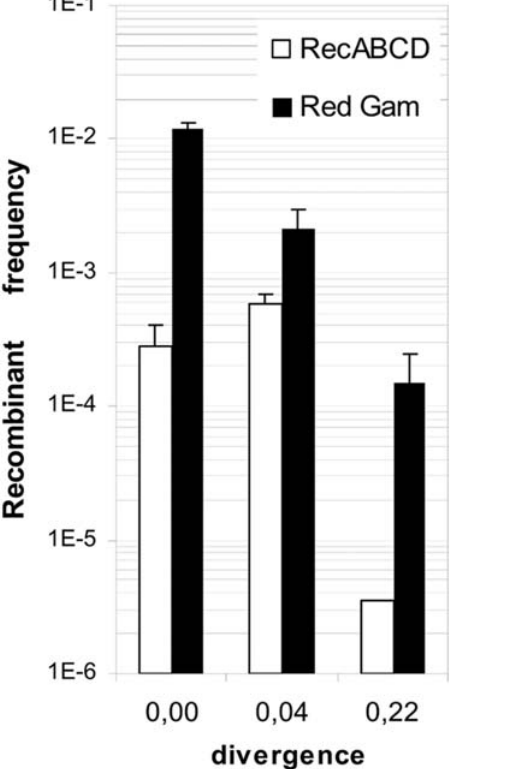
Figure 2. Frequency of recombinants in the RecABCD and the Red pathways, at different levels of sequence divergence, determined by single step growth of phages. Every bar shows the mean and standard deviation deduced from at least three experiments.